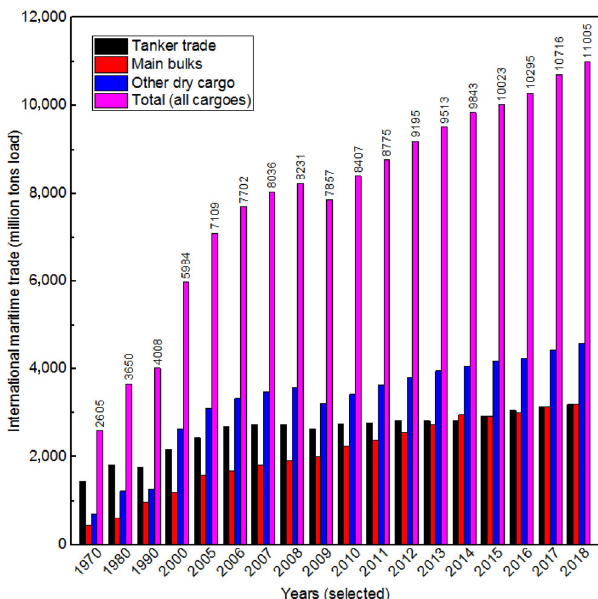
Fig. 15 Development in international maritime trade in selected years